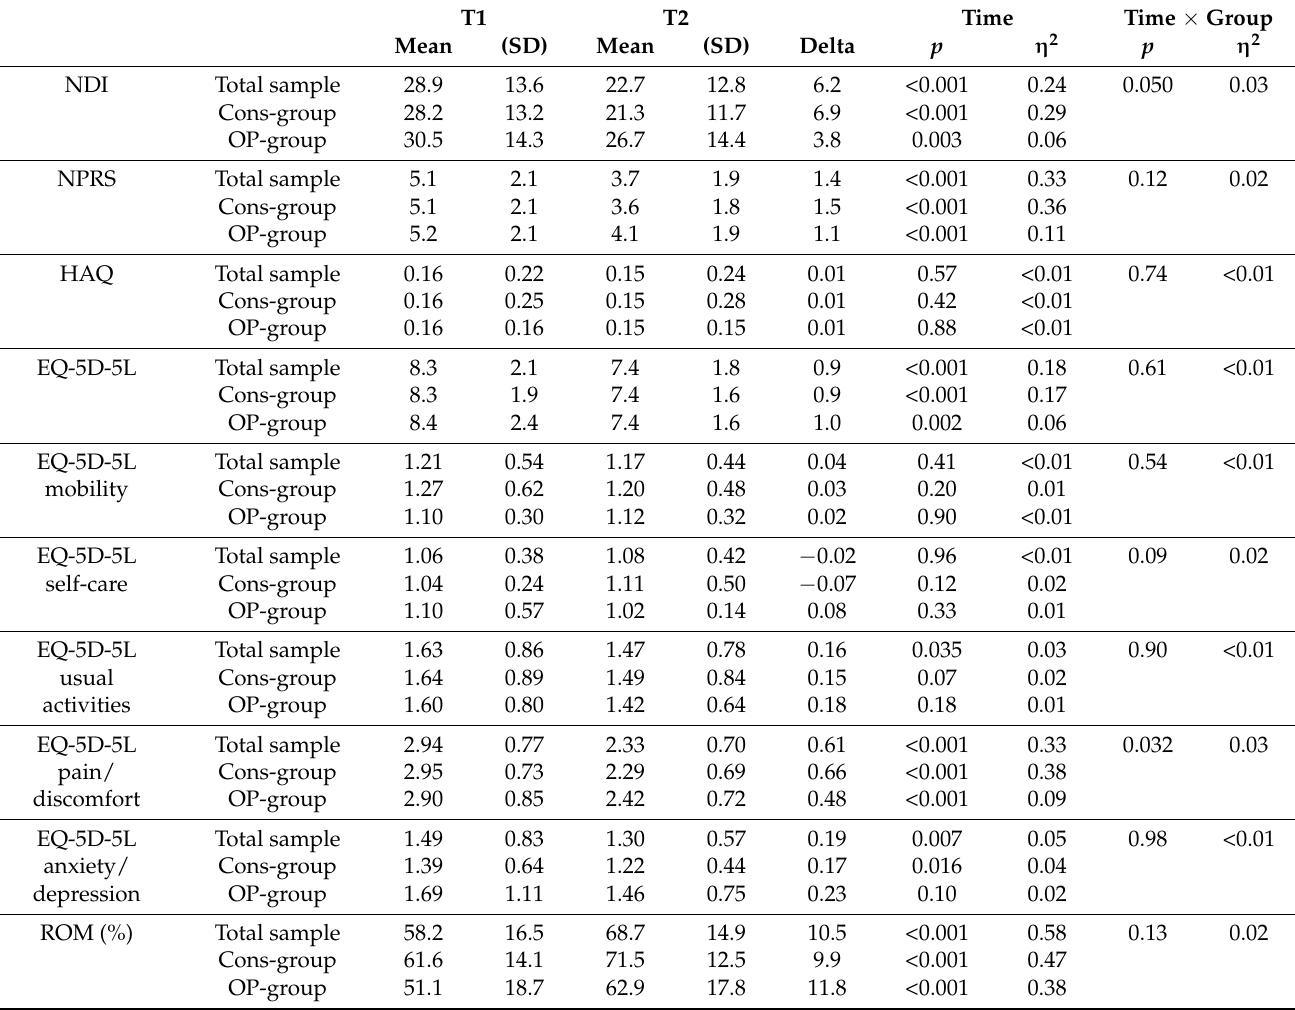
Table 5. Patient reported outcome (PRO) and range of motion (ROM) scores before and after rehabilitation treatment for total group and stratified for treatment